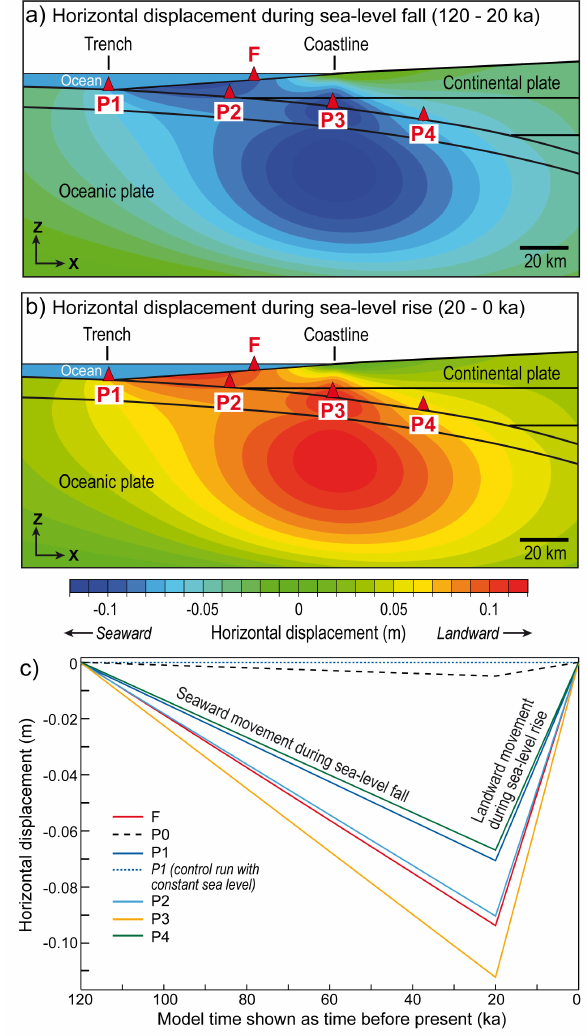
Fig. 2. Vertical displacement induced by (a) a falling sea level (120– 20ka) and (b) a rising sea level (20–0ka). (c) Temporal evolution of the vertical displacements at point F in the forearc and at points P0–P4 located on the plate interface (Figs. 1a, 2a). For reference, the result from the control run (constant sea level) is shown for point P1.